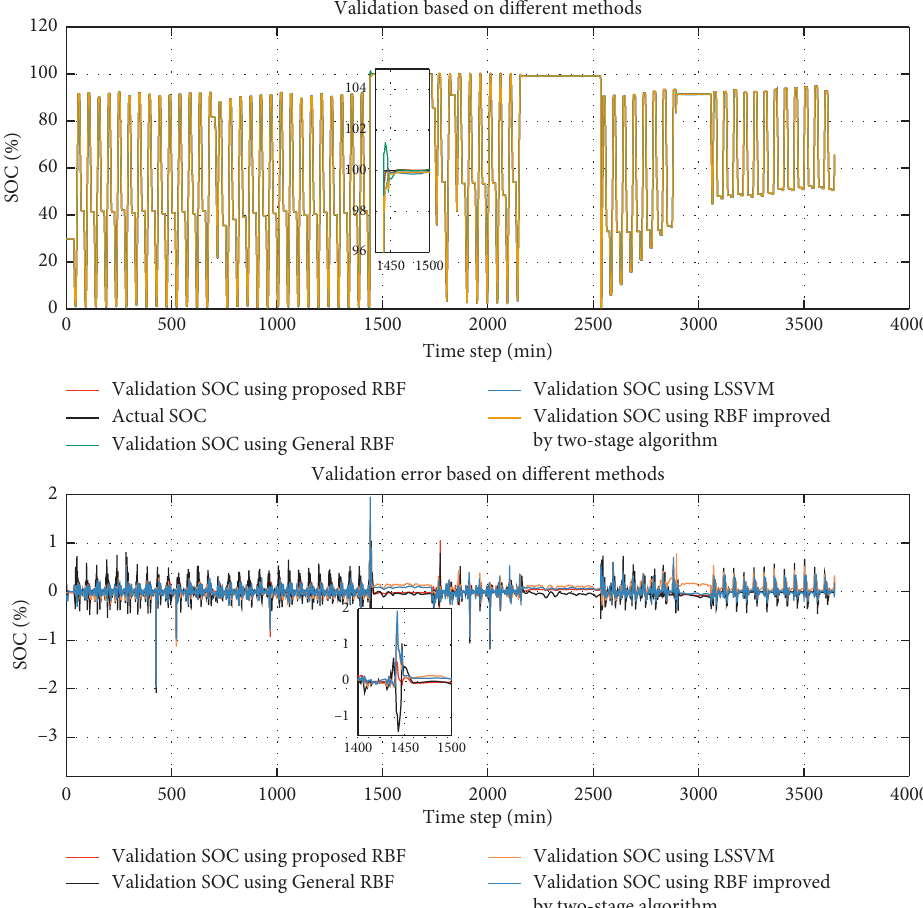
Figure 5: Validation results of the FUDS process using different